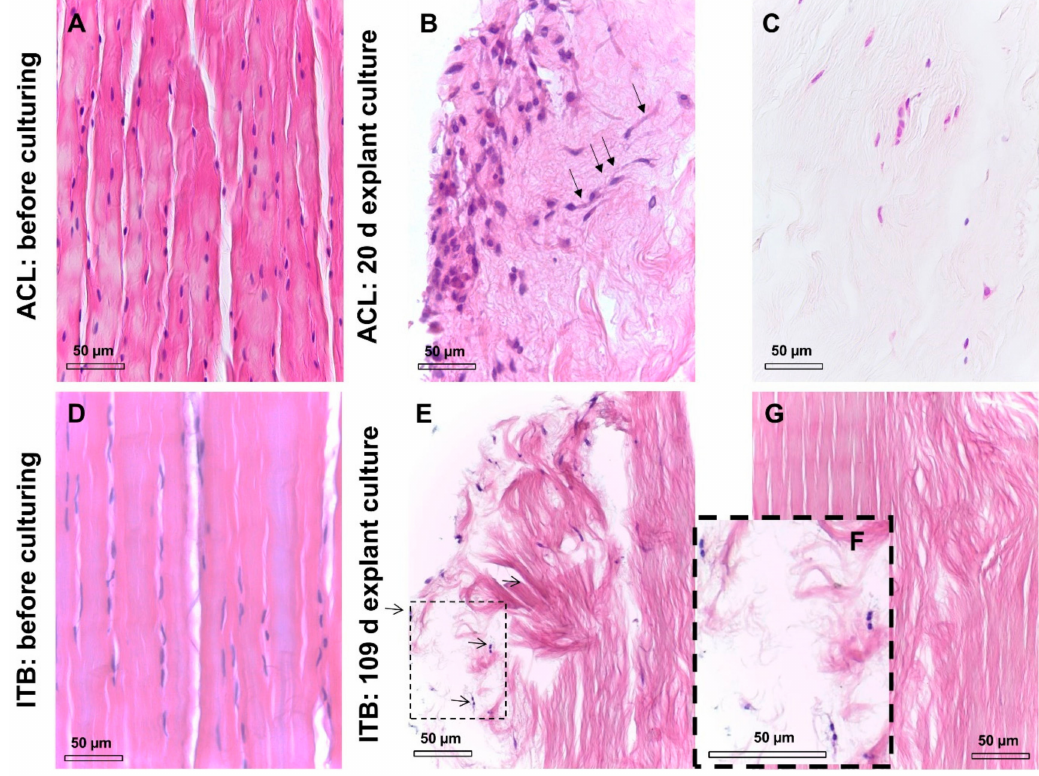
Figure 5. The HE staining of ACL and ITB tissue before and after prolonged explant culture. The tissue before culturing: ( A ) rabbit-derived ACL and ( D ) human ITB tissue. ( B ) The margin and ( C ) center of a rabbit-derived ACL explant after 20 days of culturing. In Figure 5B, the migration of ACL cells to the margin is visible (arrows). ( E ) The margin and ( G ) center of a human-derived ITB explant after 109 days of culturing. Cell divisions (zoomed in the inset ( F ) suggest cell proliferation (arrows). In Figure 5C, the core of the ACL tissue contained few inhomogeneously distributed cells after 20 days of culturing. In Figure 5G, the central part of the same ITB explant contained no cells after 109 days of culture. Scale bars: 50 µ m. ACL: anterior cruciate ligament, ITB: iliotibial